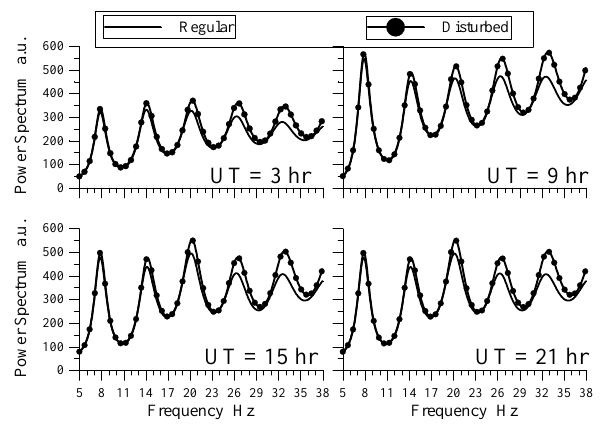
Fig. 6. Regular and disturbed fields at the Nakatsugawa observatory on particular times of the